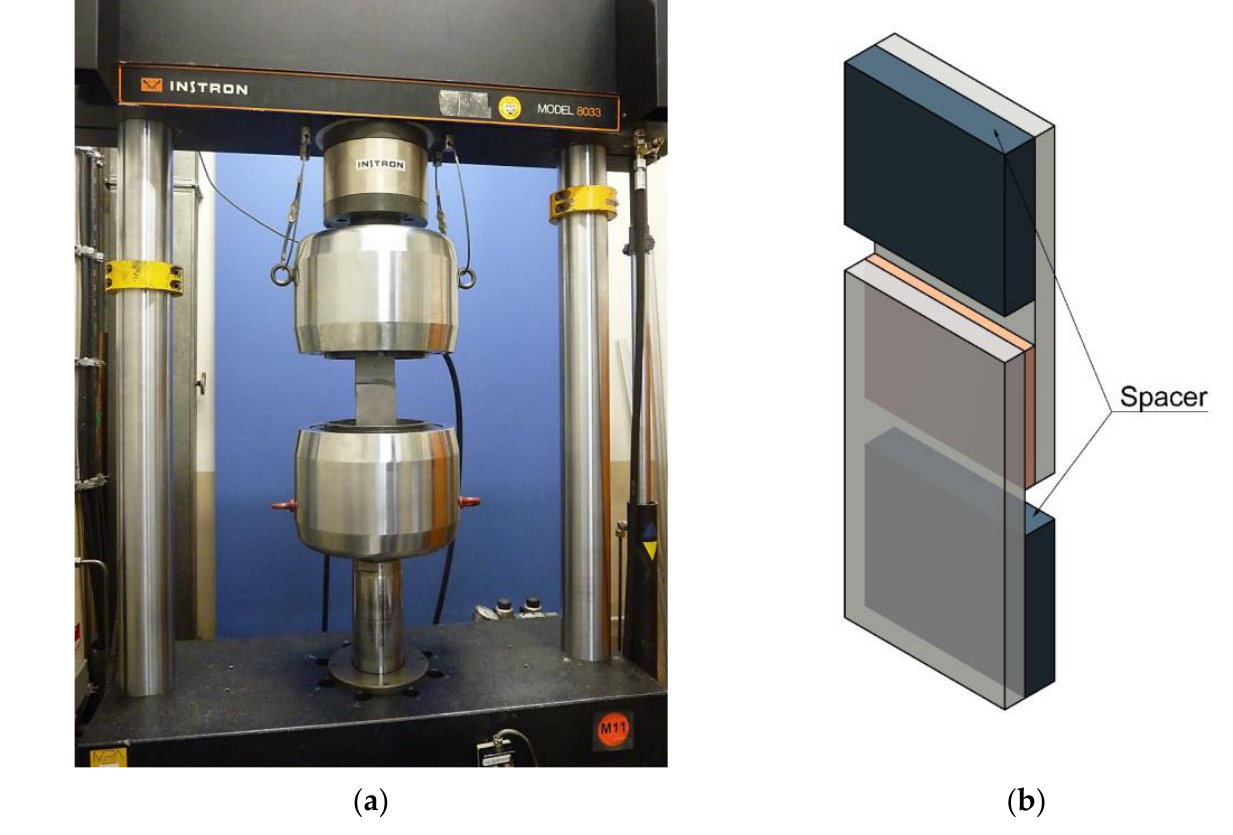
Figure 3. ( a ) Experimental set-up of the dynamic tests on adhesively bonded overlap joints [22]; ( b ) Schematic representation of an overlap joint as well as the spacers for connecting the specimen to the testing machine (coloured blue) [22]. Table 1. Test parameters and test series of the experimental investigations of the damping behaviour of the adhesively bonded overlap joints based on